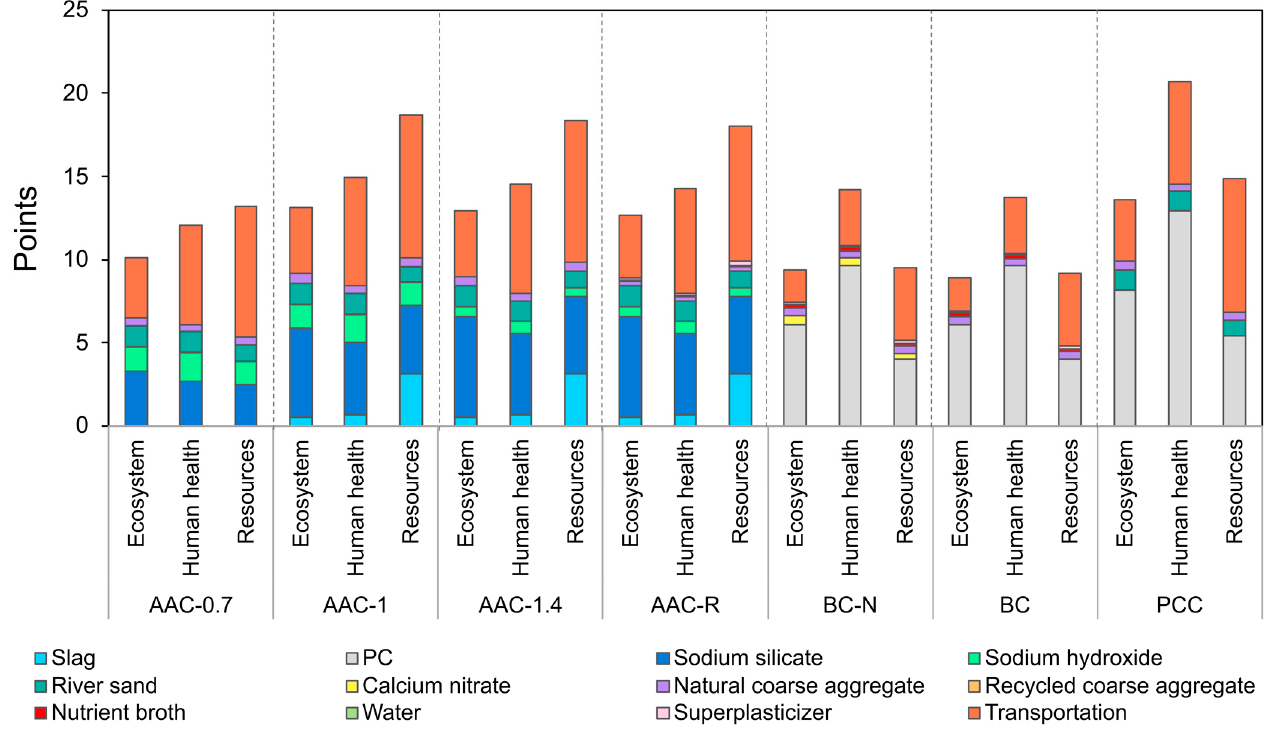
Figure 7. Endpoint environmental impact assessment of different concrete